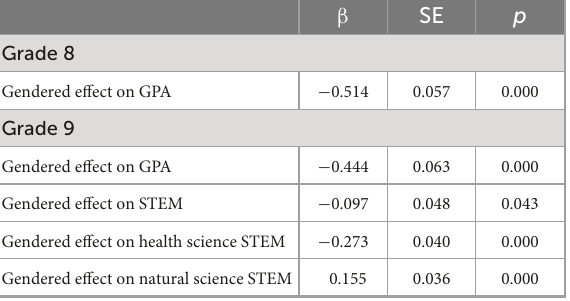
TABLE 8 Gendered effects on achievement and STEM